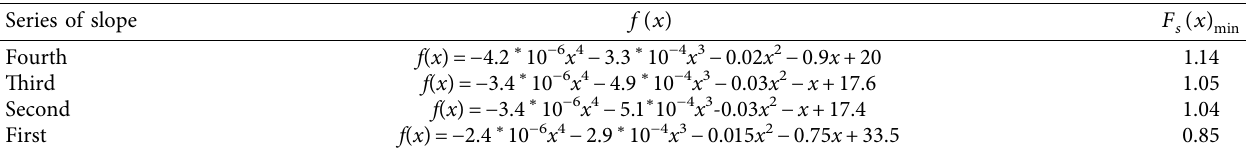
Figure 14: Te slope sliding surface calculated by the numerical simulation and model. (a) Te third- and fourth-grade sliding surfaces. (b) First- and second-order sliding surfaces. Table 2: Calculation results of composite sliding surface search model algorithm.